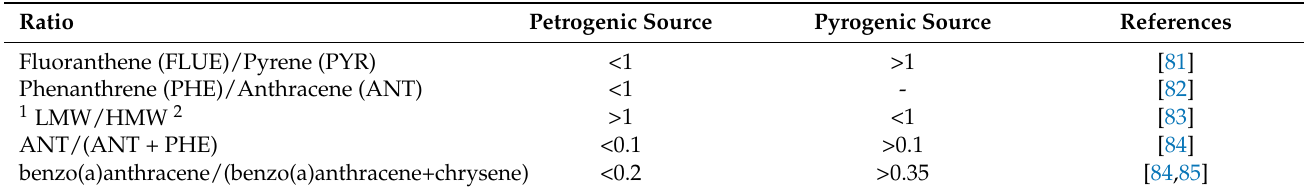
Table 7. Contamination source